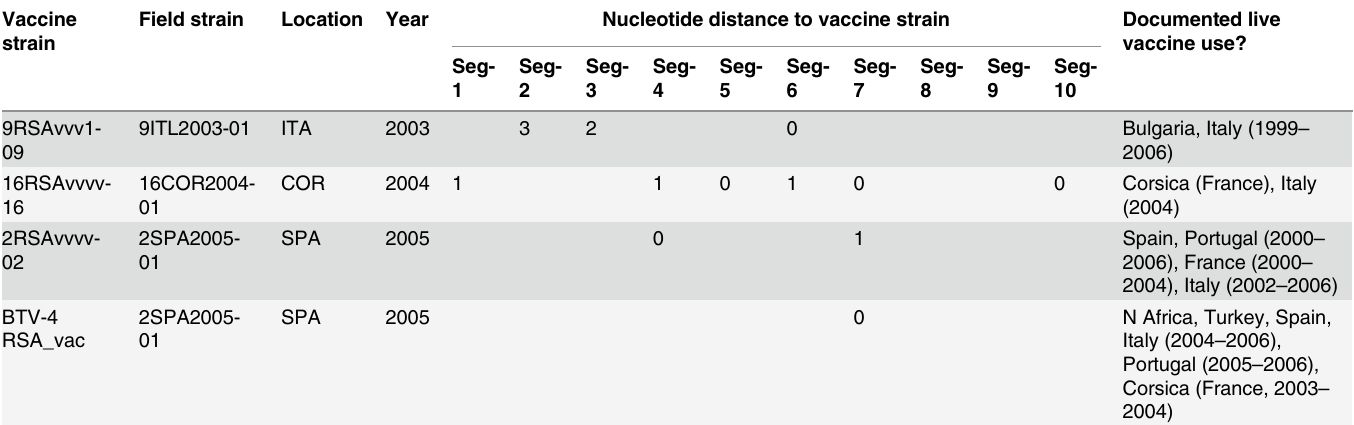
Table 4. Evidence for BTV reassortment events involving modified live vaccines in Europe. For each segment, the distance from the vaccine strain (in substitutions) is shown. Also shown are the sampling location and year for the field strain and whether use of live-attenuated vaccine in Europe or surrounding countries had been documented for the relevant time period. Information on documented use of live vaccines was taken from Savini et al. 2008